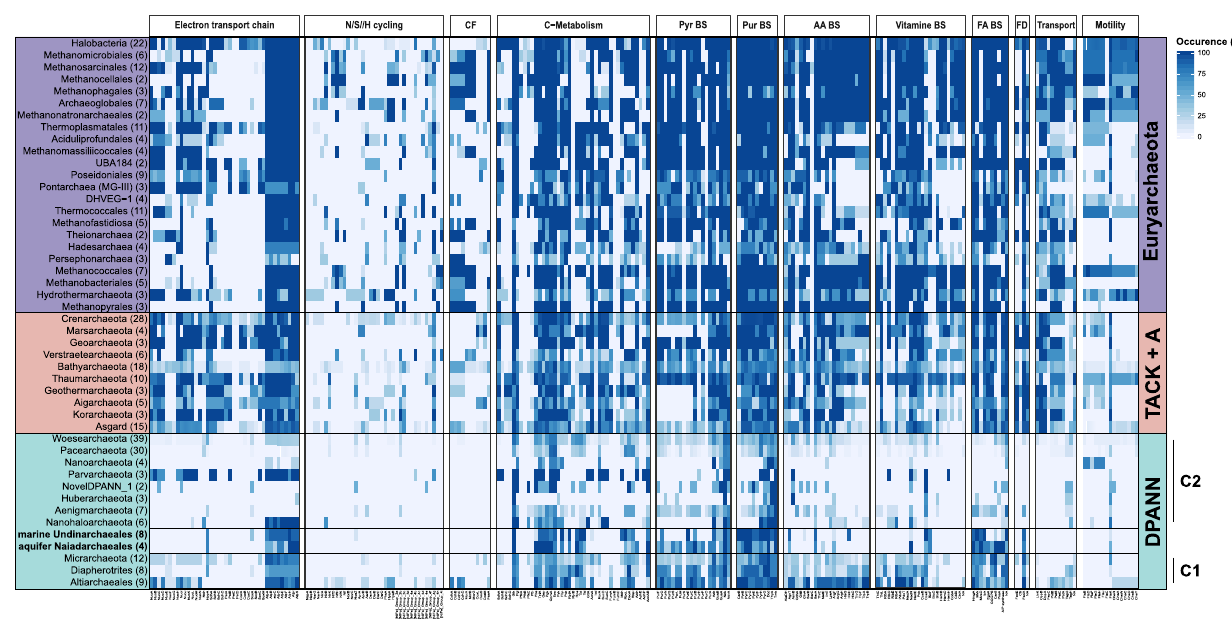
Fig. 3 Occurrence of key metabolic proteins across major archaeal lineages. Protein occurrence was calculated by detecting key proteins of interest across 364 archaeal genomes and calculating the occurrence in percent across the total number of genomes included in each phylogenetic cluster based on a presence/absence table. Number in parentheses: number of genomes included in each individual phylogenetic cluster. CF Carbon fi xation. FD Fatty acid degradation. C1/C2 DPANN Cluster 1/2. A table listing gene occurrences in archaeal lineages can be found in Supplementary Data 9 and a list of metabolic genes shown in this plot can be found in Supplementary Data